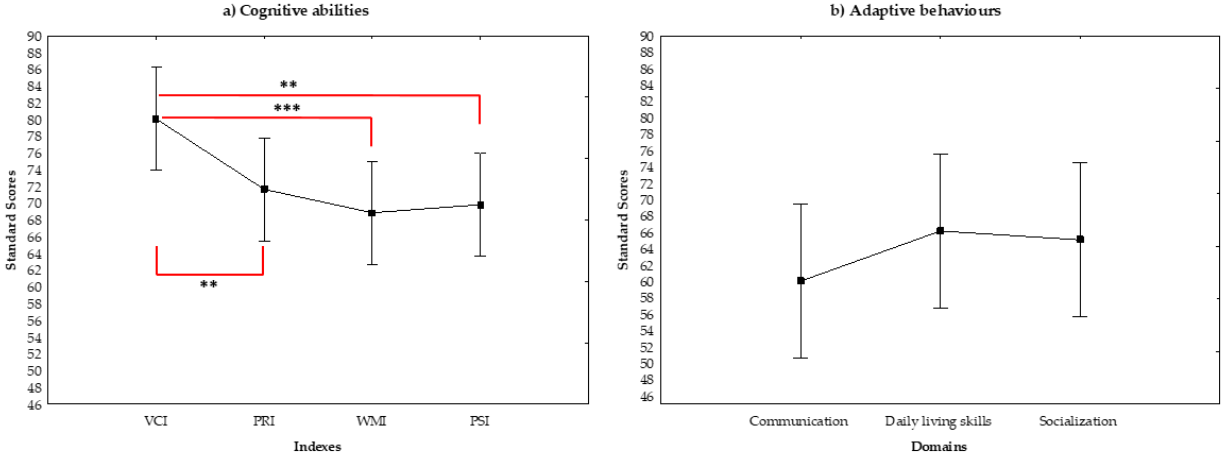
Figure 1. Panel a , b Mean of standard scores in Wechsler scale ( a ) and domains of adaptive behaviour ( b ). VCI verbal comprehension index; PRI perceptual reasoning index; WMI working memory index; PRI processing speed index; ** p ≤ 0.01; *** p ≤ 0.001.